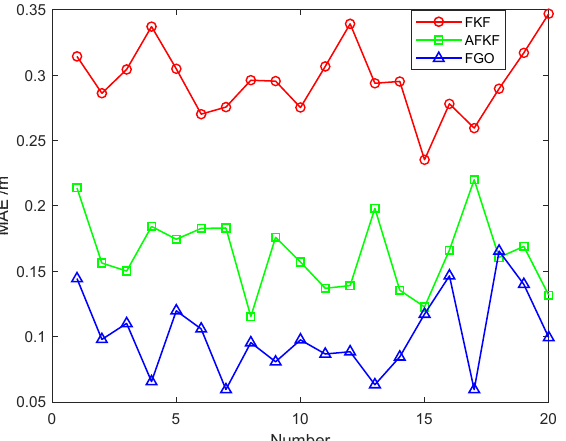
Figure 11. The MAEs of position errors (m) in 20 groups of Monte Carlo simulation experiments for the three algorithms (FKF, AFKF, and FGO).